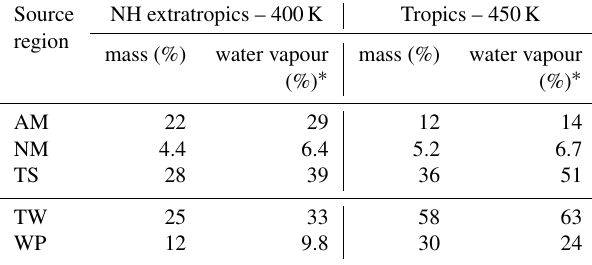
Table 2. Summary of average peak mass and water vapour